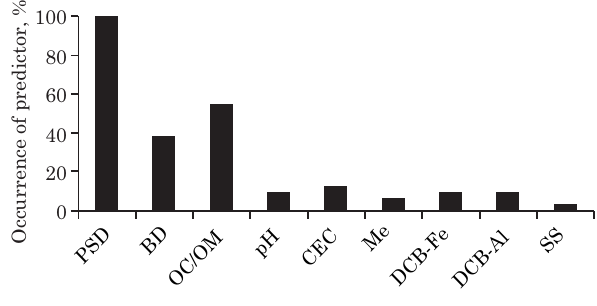
Figure 6. Occurrence of predictors of tropical pedotransfer functions in publications. PSD: particle size distribution, BD: bulk density, OC: organic carbon, OM: organic matter, CEC: cation exchange capacity, Me: moisture equivalent, DCB- Fe: dithionite-citrate-bicarbonate extractable iron, DCB-Al: dithionite-citrate-bicarbonate extractable aluminum, and SS: specific surface